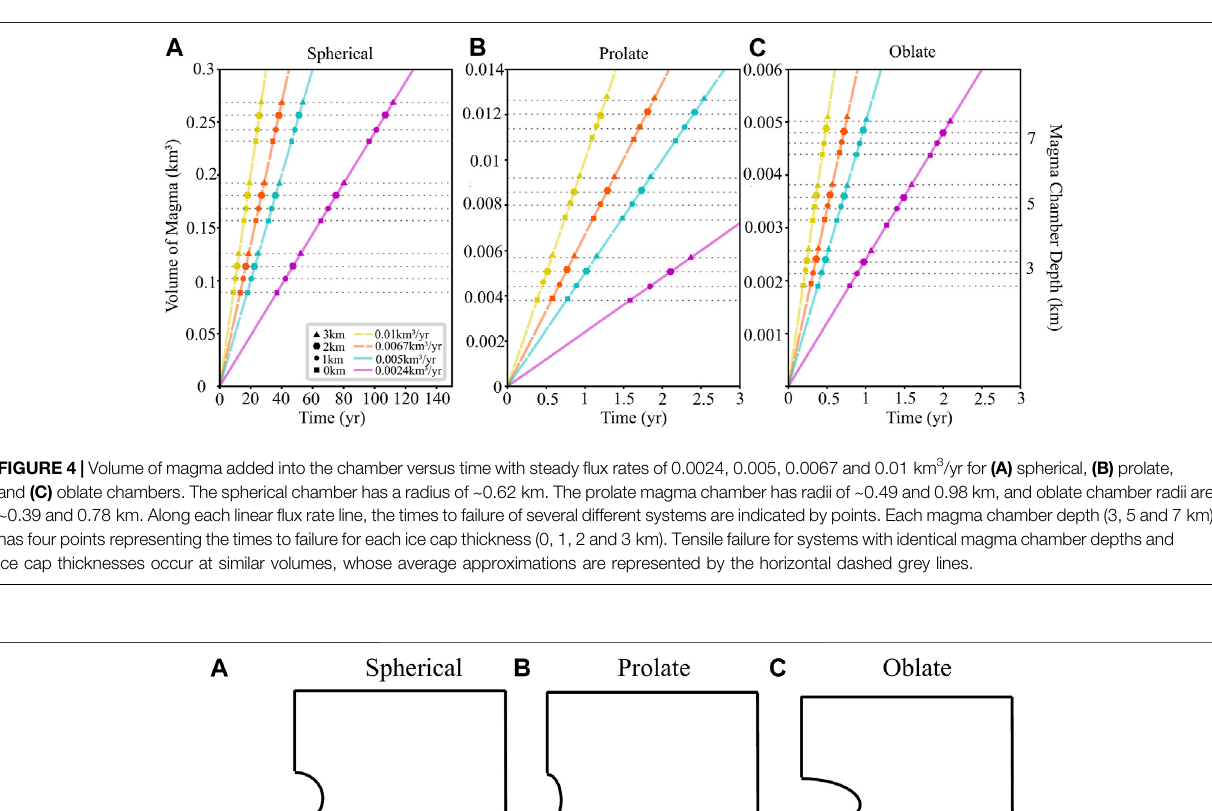
depth, shape, and ice cap thickness occurs independent of fl ux rate for similar volumes of magma added. Although the modeled magma systems indicate an insensitivity to fl ux rate, their repose intervals are highly dependent on the total magnitude of volume